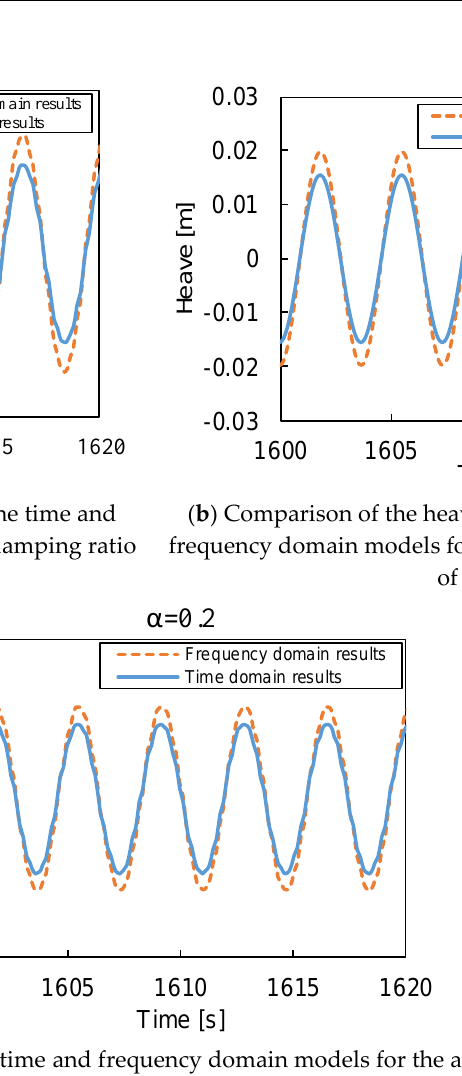
Figure 16. Comparison of windward module heave motions between frequency-domain results and time-domain results subjected to the regular wave ( H = 1 m,  = 1.7 rad/s,